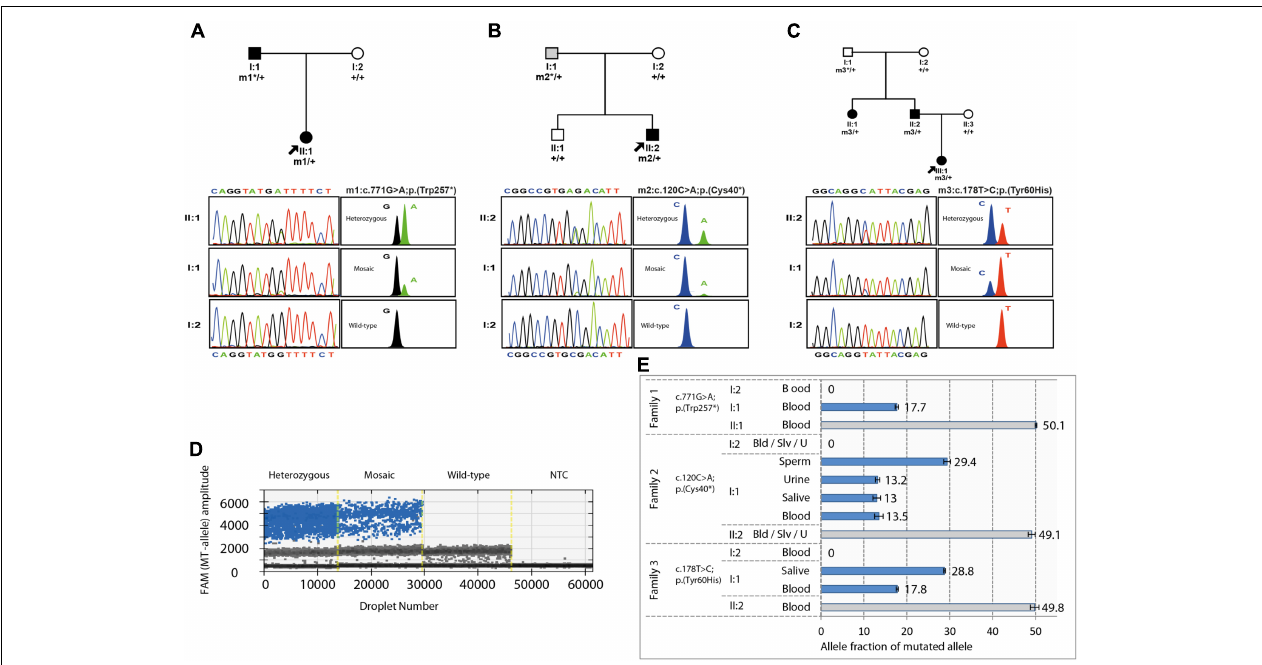
FIGURE 1 | Pedigrees, familial segregation, and mosaicism analysis of the three families carrying the PAX6 variants. (A–C) Family pedigree and segregation analysis of the heterozygous and mosaic PAX6 variants, c.771G > A (p.Trp257 ∗ ) from family 1 (A) ; c.120C > A (p.Cys40 ∗ ) from family 2 (B) ; and c.178T > C (p.Tyr60His) from family 3 (C) are shown. PAX6 variants were numbered according to RefSeq transcript NM_000280.4, using for nucleotide numbering + 1 for the translation initiation codon. Individuals with congenital aniridia or microphthalmia are indicated with black symbols, and the mosaic individual with isolated iris coloboma is indicated in gray. Probands are indicated by arrows. Sanger and SNaPshot electropherograms are shown for wild-type, heterozygous, and mosaic individuals. m1, m2 and m3 represent mutated alleles, +, wild-type alleles and ∗ indicates mosaic alleles. (D,E) . Absolute quantification of the allele abundance by Digital Droplet PCR (ddPCR) assays using Taqman SNP Genotyping assays. (D) Example of the 1-D fluorescence amplitude plot of droplets for mutant allele detection in the FAM channel in Family 2 for the heterozygous carrier (II:2), the mosaic father (I:1), a wild-type homozygous carrier (I:2), and no template control (NTC). FAM-positive droplets (blue), containing the mutant allele, exhibit increased fluorescence compared to negative droplets (gray). (E) Allele fraction of mutated allele was calculated for the FAM-positive droplets versus VIC-positive droplets (wild-type alleles). Depending on tissue availability, somatic cells from blood (Bld), saliva (Slv), sperm and urine (U) samples were tested in the suspected mosaic individuals (I:1) from each family and compared to their respective probands and healthy individuals as fully heterozygous and wild-type controls. In Family 2, sperm cells from the mosaic father were tested to calculate the recurrence